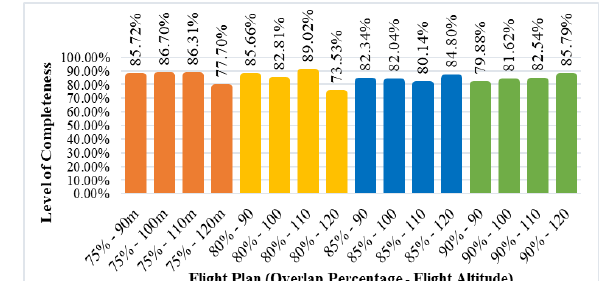
Figure 10 . Bar Graph for the visualization of flight plans based on the level of completeness with respect to overlap percentage and flight altitude .